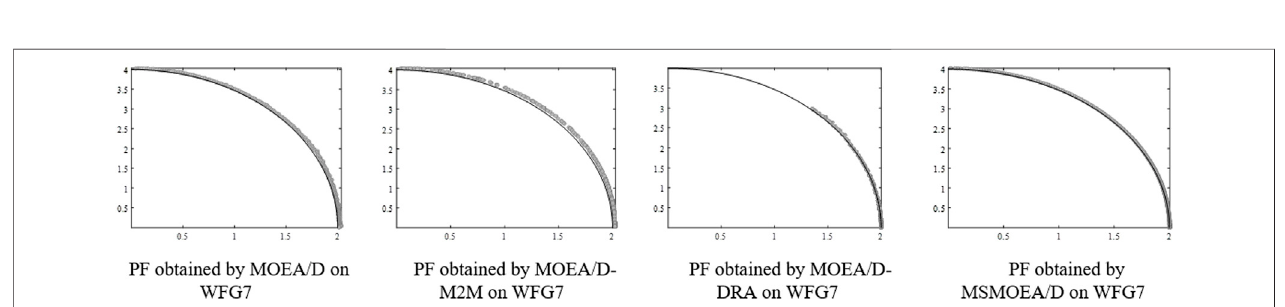
FIGURE 14 | PF obtained by MSMOEA/D and MOEAs on two-objective WFG7.